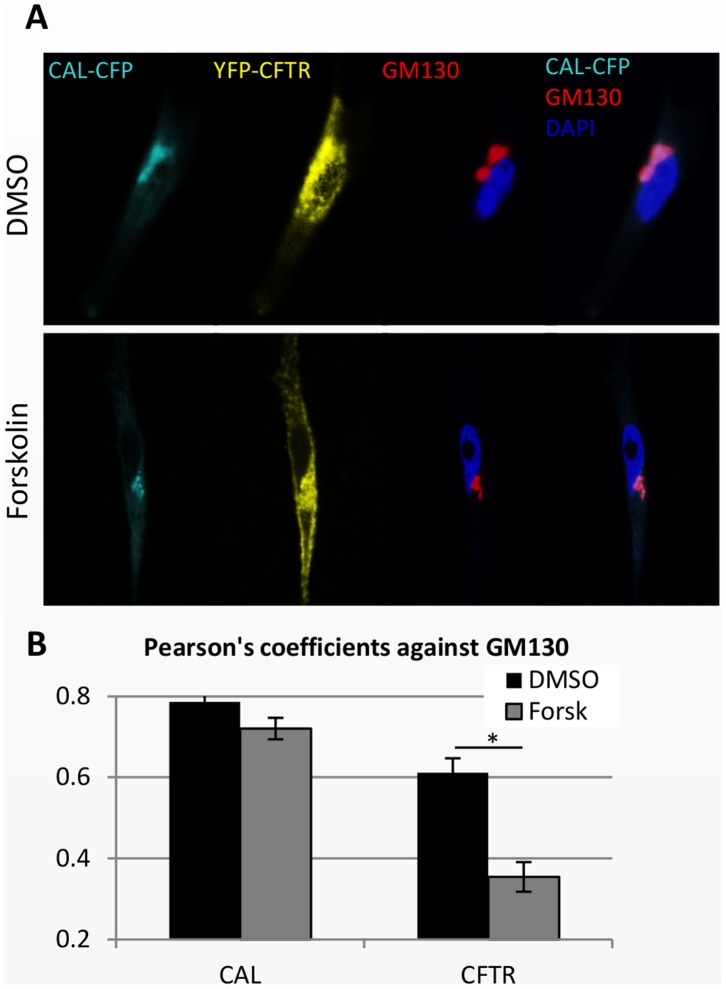
Forskolin treatment relocates CFTR, but not CAL, out of the Golgi in HeLa cells.HeLa cells were transfected with CAL-CFP (0.5 µg) and YFP-CFTR (1.5 µg). GM130 was immunostained with anti-GM130 antibody, followed by secondary antibody conjugated with Alexa-647. DMSO (A, upper panel) or 100 µM forskolin (A, lower panel) was added at 37°C for 30 minutes. (B) The graph shows Pearson’s correlation coefficients of GM130 and CAL or of GM130 and CFTR. The coefficients were calculated using an ImageJ plugin, the Colocalization Test. Pearson’s correlation coefficients of GM130 and CAL-CFP were not altered in the presence of forskolin, but those of GM130 and YFP-CFTR were reduced by forskolin treatment. Results are means ±SE. (n = 6–9) *p<0.01.